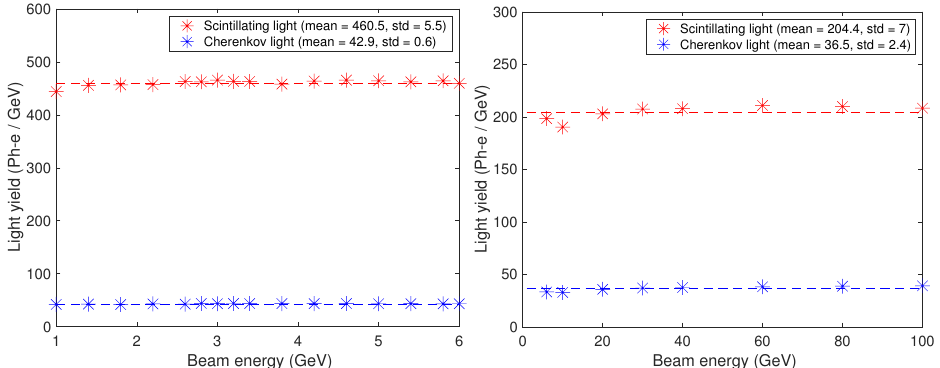
Figure 6. Average number of scintillating and Cherenkov photo-electrons/GeV detected by the highly granular module as a function of the electron beam energy. The results from DESY are on the ( left ) and the results from the CERN test beam analysis on the ( right